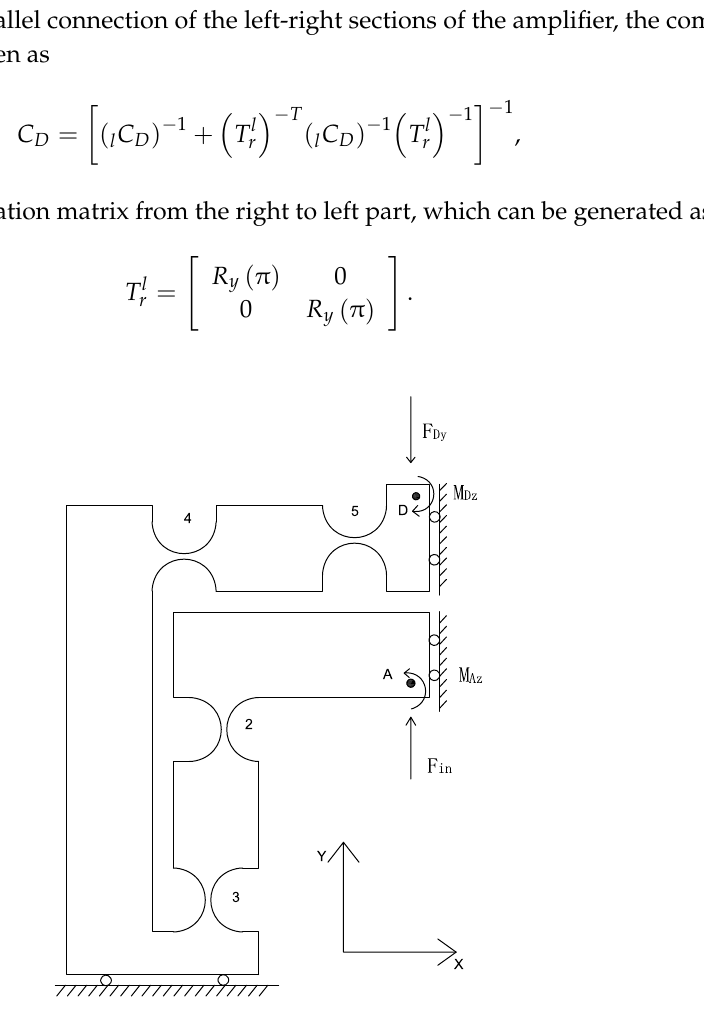
Figure 8. Coordinates for one quarter of the displacement